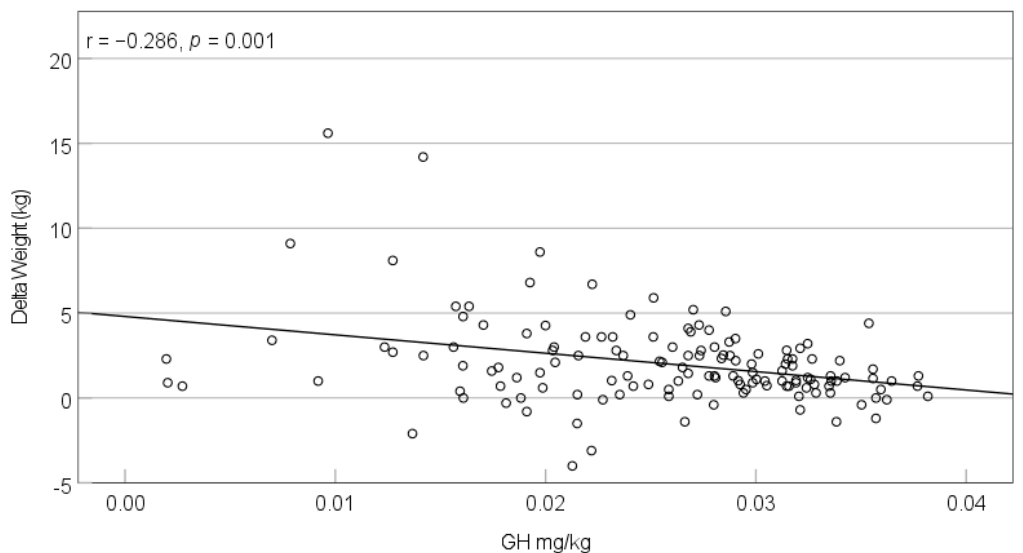
Figure 1. Correlation between the intra-lockdown GH dosage (mg/kg) and weight change (kg) during the lockdown period